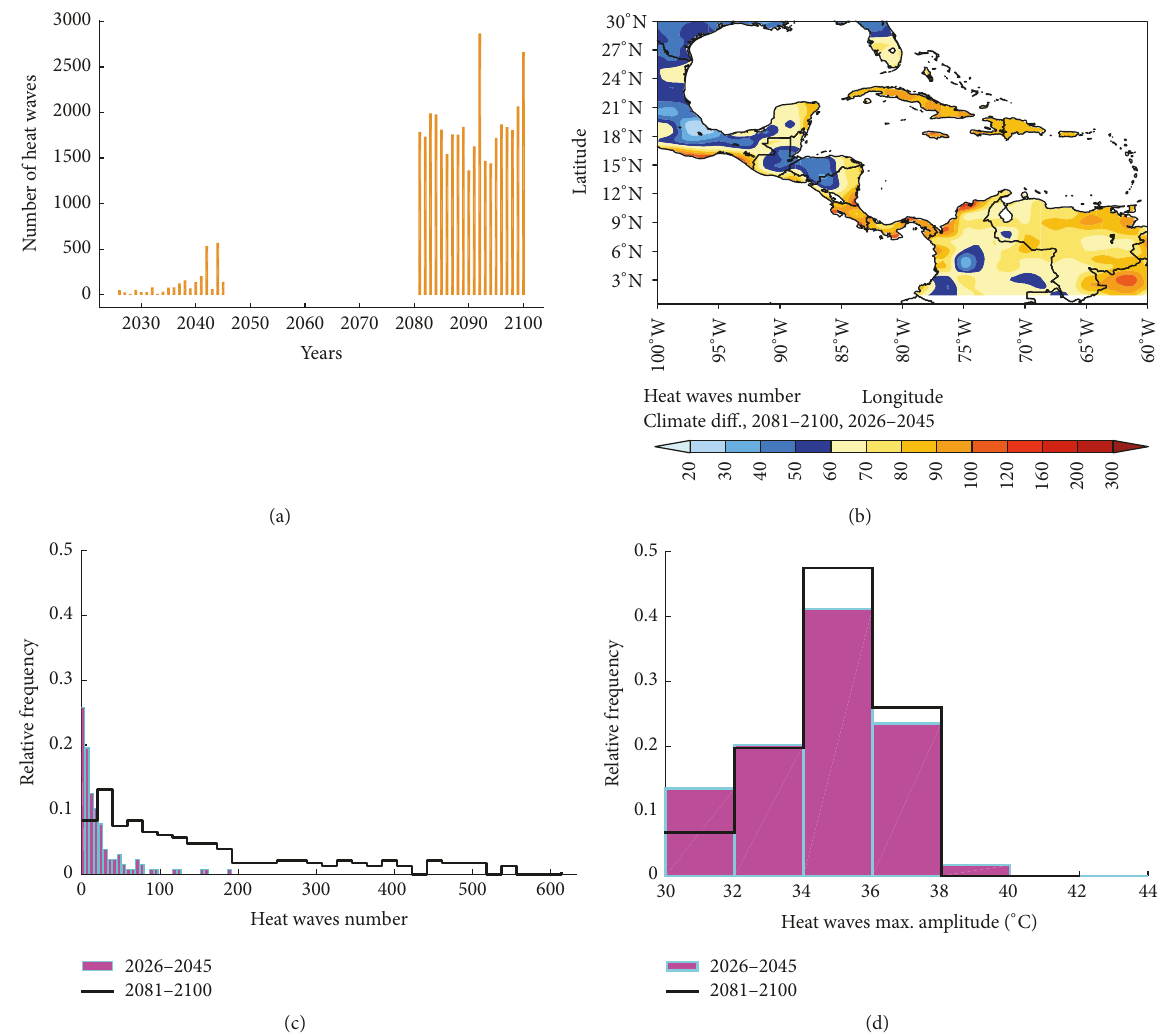
Figure 8: Multimodel ensemble mean for the RCP4.5 scenario: (a) annual time series, (b) HWs number change between the climate periods 2081–2100 and 2026–2045, (c) HWs frequency of the whole IAR including the ocean area, and (d) regional average of HWs maximum